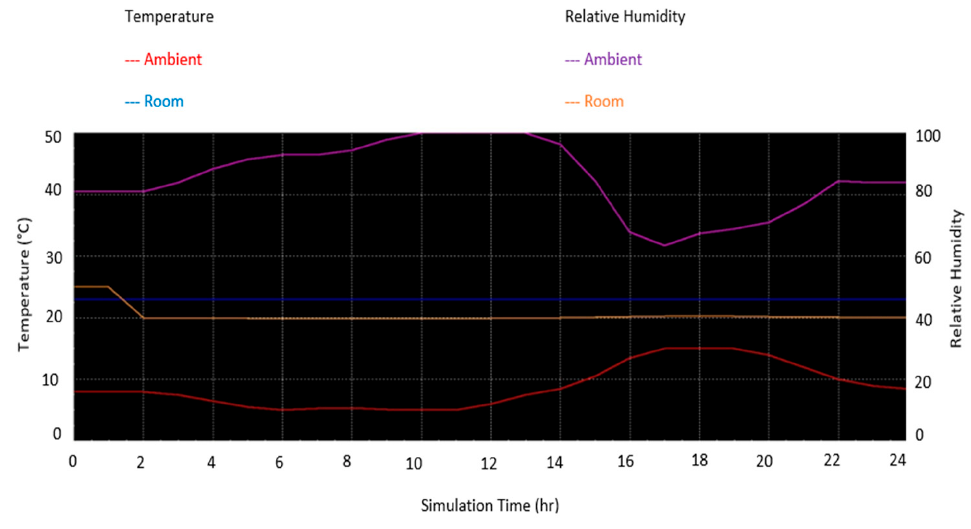
Figure 14. 1st January simulation run for option B.